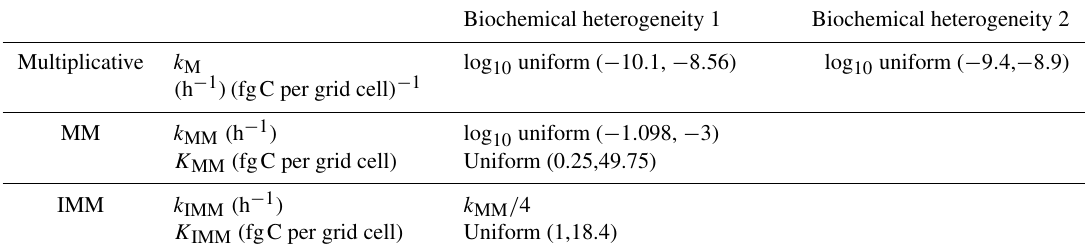
Table A3. Probability distributions of the parameters for the multiplicative, MM, and IMM kinetics models. Values in brackets indicate the minimum and maximum parameter values.